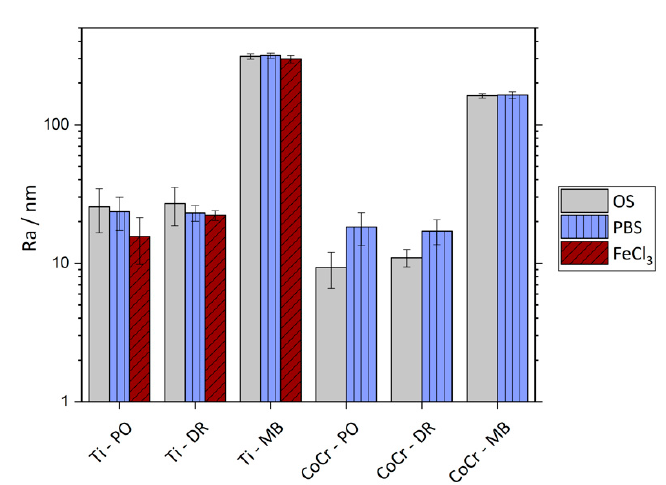
Figure 9. R a values (nm) for Ti6Al4V and CoCrMo in polished, deep-rolled and microblasted surface condition. “Original surface” (OS) refers to the region which had not been in contact with the electrolyte during electrochemical testing; PBS refers to the surface after being electrochemically tested in PBS; FeCl 3 refers to the surface after being electrochemically tested in FeCl 3 -containing electrolyte. Table 4. R a and R z values in nm for all tested materials, surface conditions and electrolytes. Ti6Al4V /